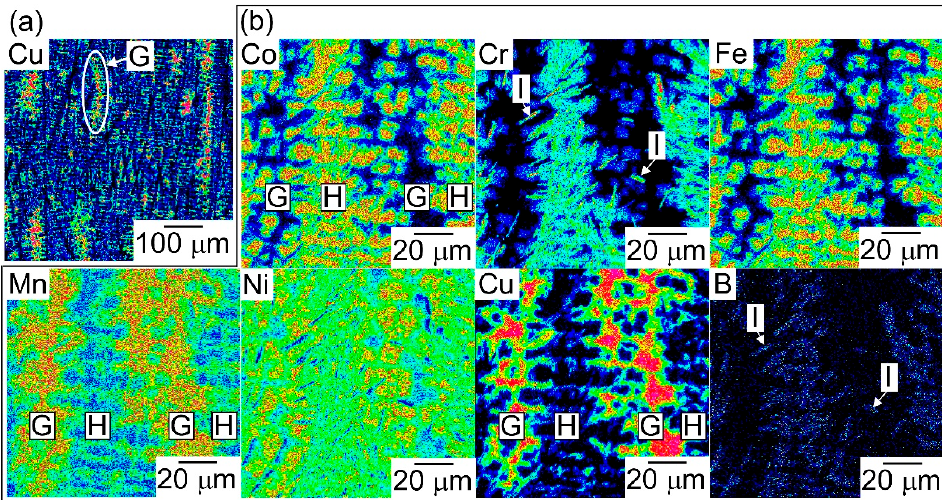
Figure 9. Element mapping of the arc-melted ingots of the B-added CoCrCuFeMnNiB 0.2 (Cu1B02) using EPMA-WDS. ( a ) Cu element mapping focusing of region G as depicted in Figure 8a, ( b ) element mapping corresponding to Figure 8b. Table 2. Chemical composition analysis results of the ratio of metallic element without considering B (atomic percent ratio) in the arc-melted ingots of the CoCrCuFeMnNiB 0.2 (Cu1B02) HEA evaluated using WDS.